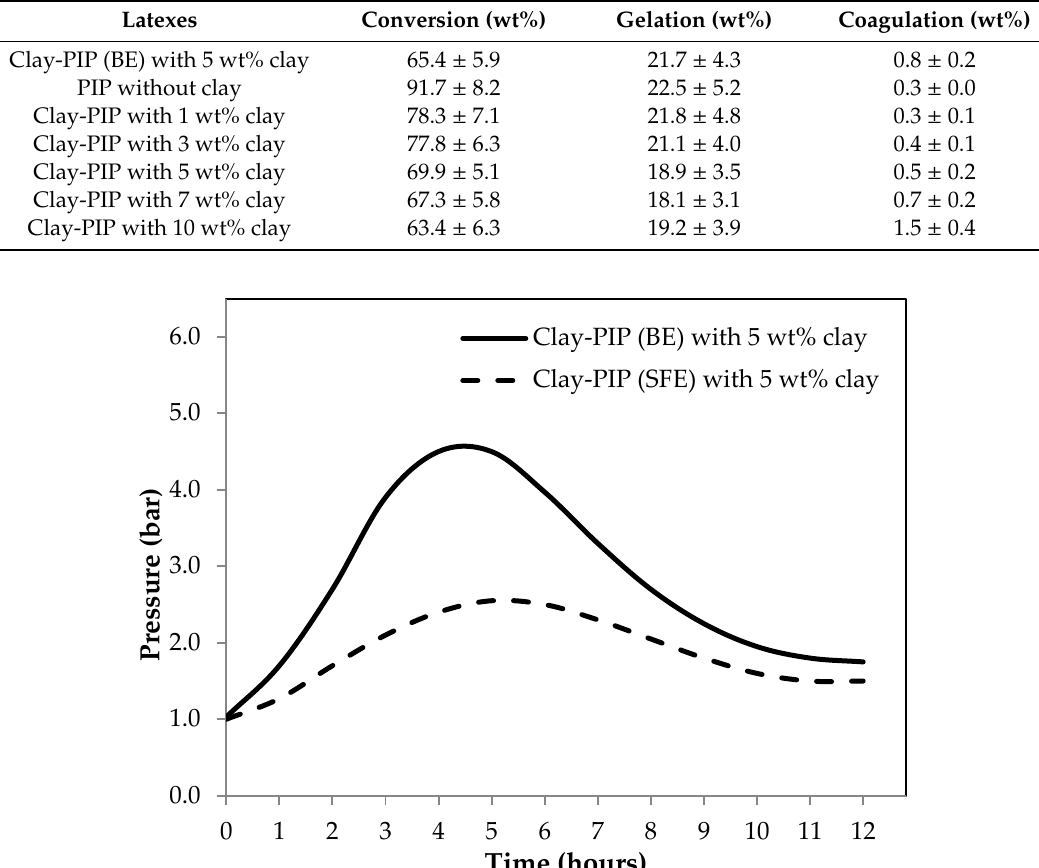
Figure 1. Real-time monitoring data of the internal reactor pressure as a function of reaction time of synthesizing Clay-PIP latexes through batch (BE) and starve-fed (SFE) emulsion polymerization techniques. The organo-nanoclay at 5 wt% relative to the monomer content was employed.